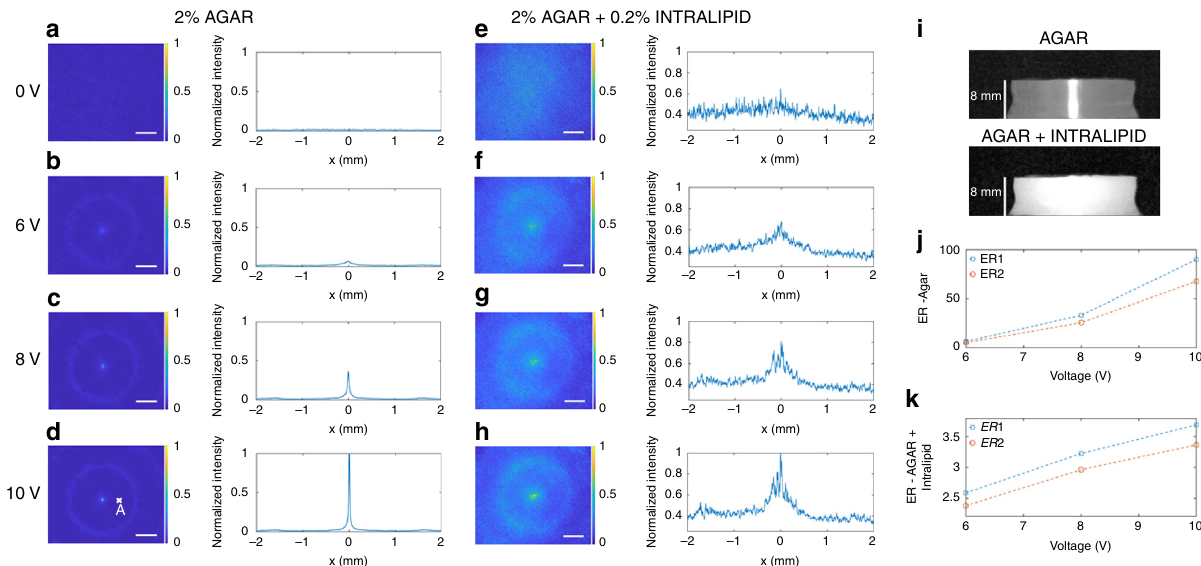
Fig. 3 Light is con fi ned within tissue phantoms. Optical beam pro fi le imaged experimentally 100 μ m below the top surface of the tissue phantom in agar and in a scattering tissue phantom. a – d 2D cross-sections of the optical beam pro fi le and radial cross-section plots in 2% agar when ultrasound is: a off, b driven at 6 V, c 8 V, and d 10 V. In each case, the intensity has been normalized to the maximum intensity of ( d ). e – h 2D cross-sections of the optical beam pro fi le and radial cross-section plots in a scattering tissue phantom composed of 2% agar mixed with 0.2% Intralipid when ultrasound is: e off, f driven at 6 V, g 8 V, and h 10 V. In each case, the intensity has been normalized to the maximum intensity of ( h ). Side view of agar and the scattering tissue phantoms shown in i when illuminated by a narrow (2 mm) collimated beam of laser. Extinction ratios measured according to the de fi nition of Extinction Ratio 1 (ER1) (blue) and Extinction Ratio 2 (ER2 ) (orange) in: j 2% agar and in k the scattering tissue phantom. The scale bar is 1